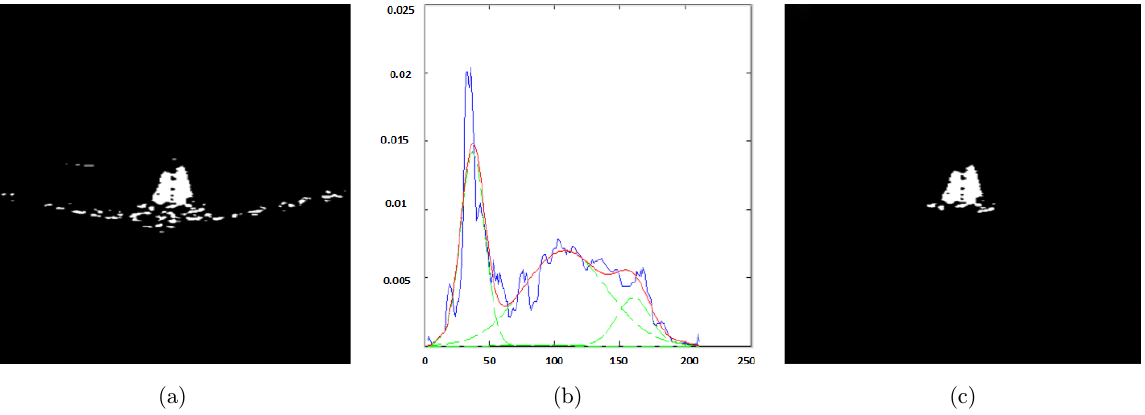
Fig. 4. We have 3 sub¯gures. (a) The mask image has not been processed by distance thresholding, (b) The distance probability of each pixel to the IB-RPE layer and (c) The image after restricting the region using distance.